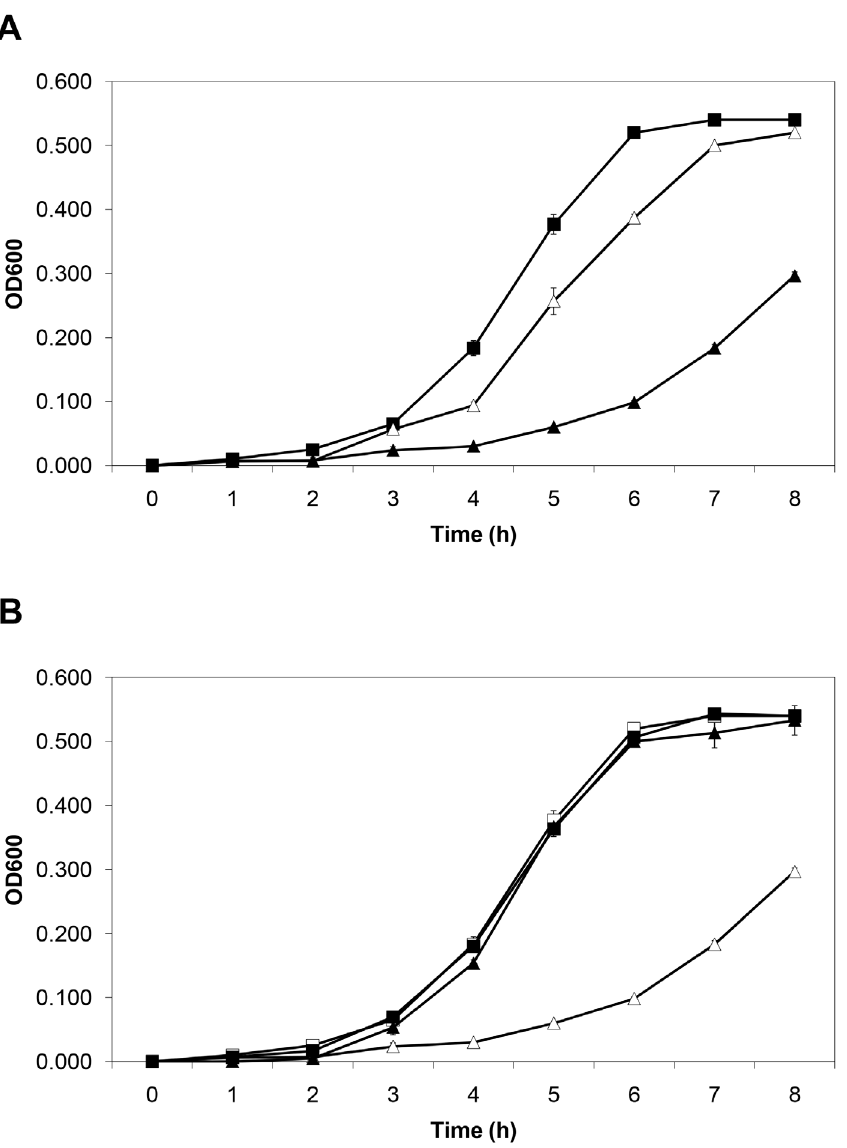
Figure 1. Effect of bovine lactoferrin concentrations on ETEC H10407 growth. A) Effect of two lactoferrin concentrations on ETEC H10407 growth. Bacteria were incubated on Luria Broth (control) ( & ) or bovine lactoferrin at 1.0 mg/mL ( D ) or 10.0 mg/mL ( m ) for 8 h. Bacterial growth was monitored spectrophotometrically at OD600 for 8 h. B) Effect of iron and lactoferrin on ETEC growth. Bacteria were incubated in Luria Broth (control) with ( & ) or without iron ( % ), or bovine lactoferrin at 10 mg/mL with ( m ) and without iron ( D ) (4:1 molar ratio of iron to lactoferrin). Bacterial growth was monitored spectrophotometrically at OD600 for 8 h (mean 6 SD of 3 experiments). The SD bars are not seen in the majority of the samples because they fall inside the